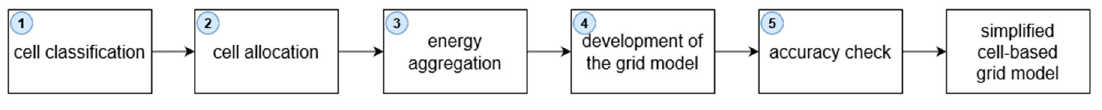
Figure 4. Overview: development of a simplified cell-based model.